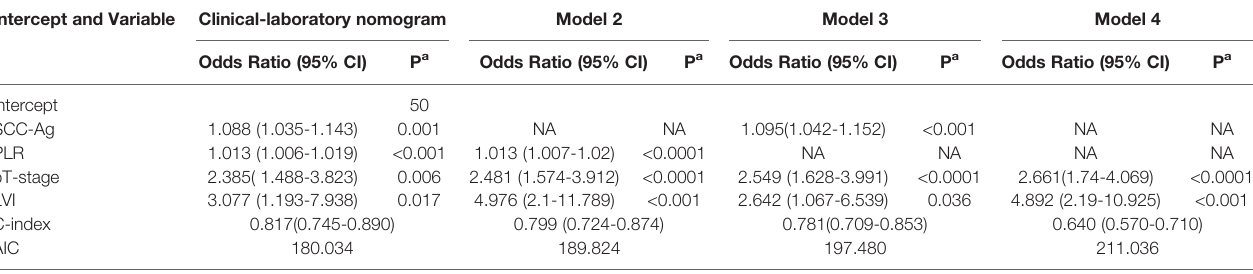
TABLE 4 | Comparisons of different predictive models of Lymph Node ENE in Penile cancer. Intercept and Variable Clinical-laboratory nomogram